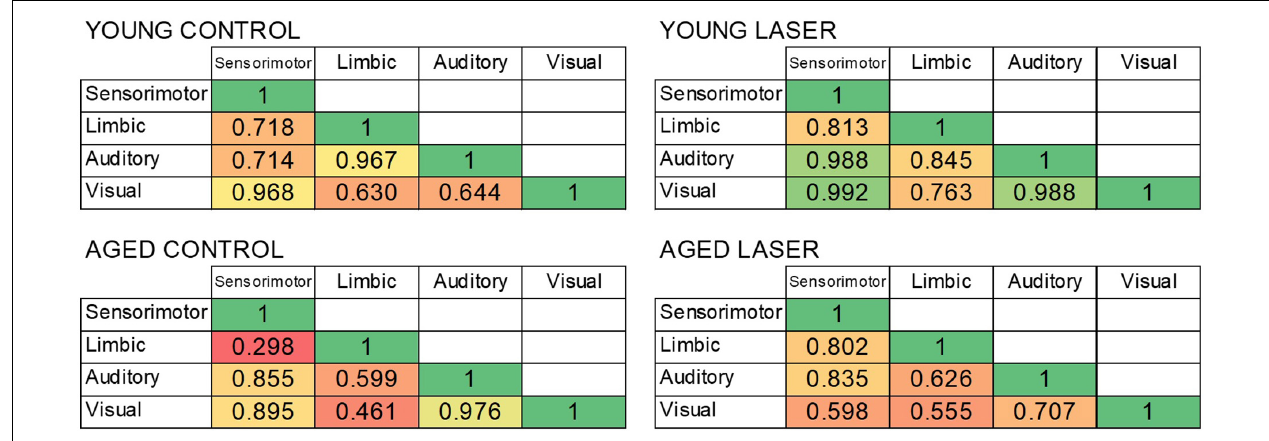
FIGURE 7 | Bivariate correlations between the four functional systems showing significant differences in CCO activity in rats from young laser (YL; n = 5), young control (YC; n = 7), aged laser (AL; n = 6) and aged control (AC; n = 6). The heat map shows weaker correlations in red/orange and stronger correlations in